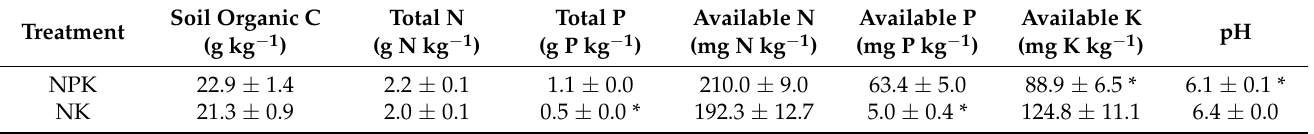
Table 1. Influences of long-term P fertilizer amendment on soil properties.